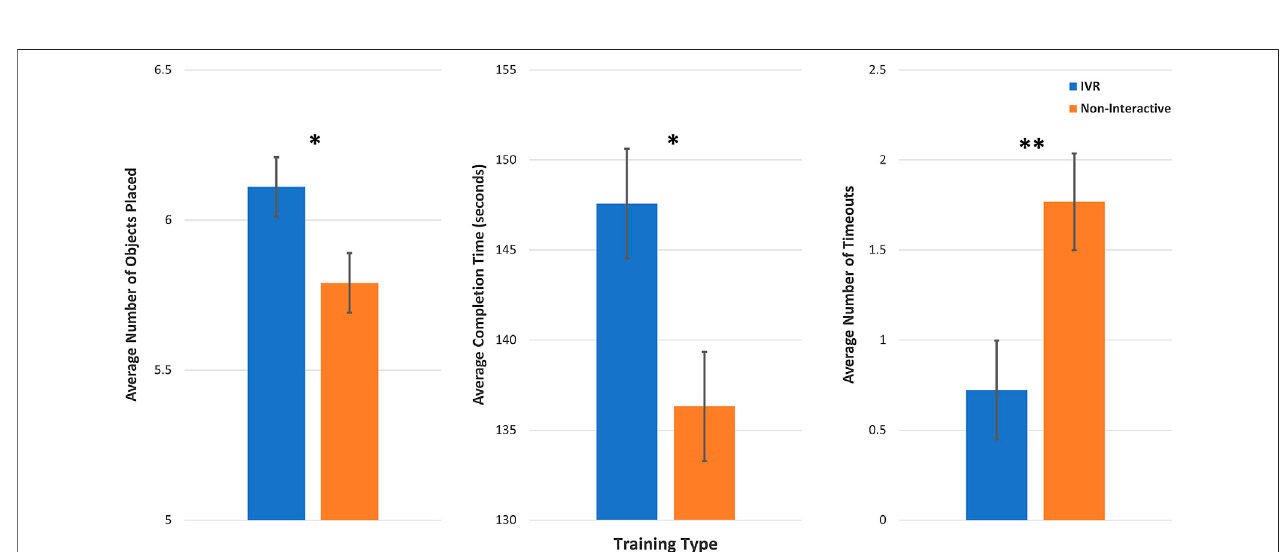
FIGURE 3 | Behavioral results in real-world task across IVR and non-interactive training groups.